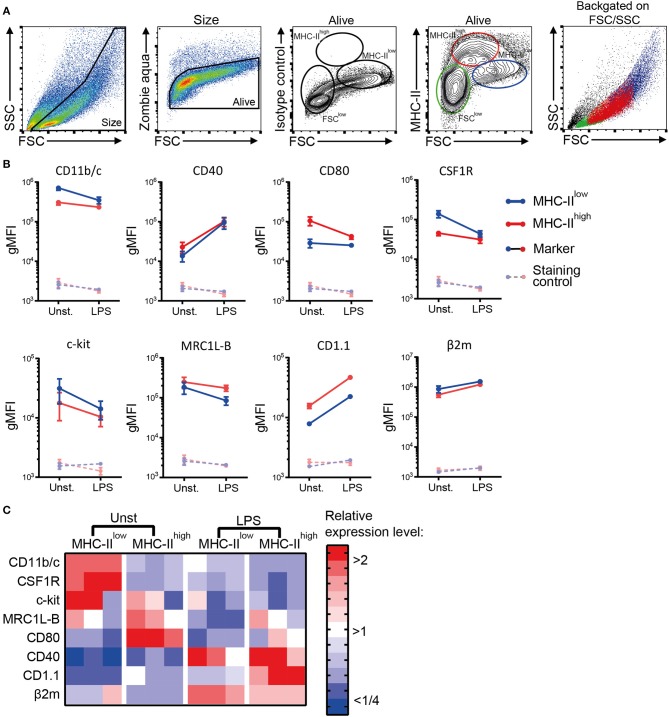
The phenotypic distinction between major histocompatibility complex class II (MHC-II)low and MHC-IIhigh chicken bone marrow-derived dendritic cells (chBMDCs) is not retained after 24 h of lipopolysaccharide (LPS) stimulation. (A) LPS-stimulated chBMDCs were gated by a similar strategy as Figure 2A. (B) The change in myeloid marker expression upon LPS stimulation is shown for both MHC-IIlow and MHC-IIhigh chBMDC subsets. The error bars show the SEM of three independent replicates. (C) The expression of phenotypic markers is shown in a heat-map for unstimulated and LPS-stimulated MHC-IIlow and MHC-IIhigh chBMDCs. To obtain the relative expression level for each marker, the gMFI of each sample was normalized to the average gMFI of all samples.